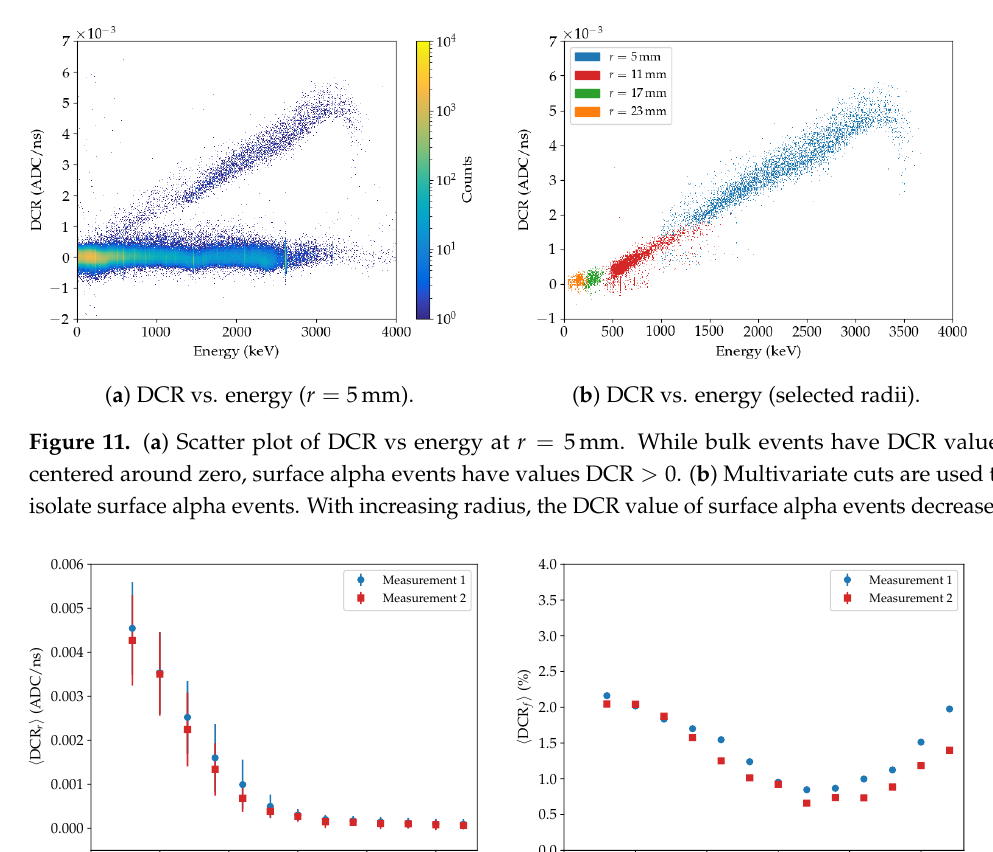
DCR r and ( b ) DCR f for two radial 241 Am scans at different (cid:104) (cid:105) (cid:104) (cid:105) DCR r (cid:104) (cid:105) DCR f , which is defined as / , where E ex α E obs α E ex α (cid:104) (cid:105) (cid:104) (cid:105) (cid:104) (cid:105) (cid:104) (cid:105)